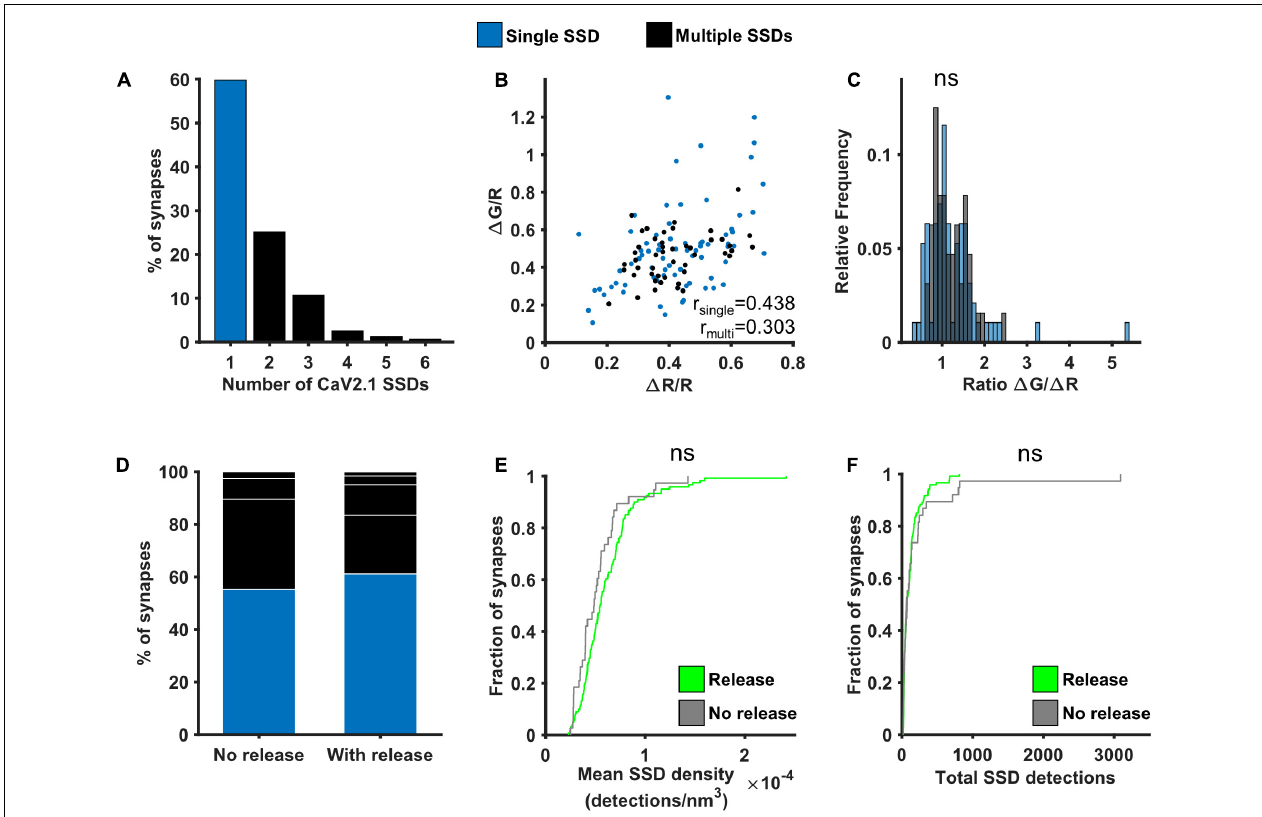
FIGURE 5 | Effect of Cav2.1 nanoscale organisation on neurotransmitter release. (A) Distribution of the number of Cav2.1 SSDs per synapse. (B) (cid:49) G/R and (cid:49) R/R responses from synapses post hoc labelled for Cav2.1 and identified as containing a single (blue) or multiple Cav2.1 SSDs (black) show a positive correlation (Spearman’s rank correlation, r single = 0.439, p < 0.0001, n single = 74 synapses; r multi = 0.303, p < 0.0001, n multi = 47 synapses). (C) Distribution of the ratio (cid:49) G/ (cid:49) R for the two group of synapses. Distributions are not significantly different (Kolmogorov-Smirnov test, p = 0.657, n single = 74, n multi = 47). (D) Percentage of synapses with single or multiple Cav2.1 SSDs in synapses without detectable release (left, n = 38) or with release (right, n = 121). White lines indicate separation of multiple SSDs by number. (E) Cumulative frequency distribution of the mean density of detections in Cav2.1 SSDs per synapse (number of detections/nm 3 ) in synapses with (green) or without (grey) detectable release to a 10AP stimulus (Kolmogorov-Smirnov test, p = 0.122, n release = 121, n norelease = 38). (F) Cumulative frequency distribution of the total number of detections in Cav2.1 SSDs per synapse in synapses with (green) or without (grey) detectable release to a 10AP stimulus (Kolmogorov-Smirnov test, p = 0.820, n release = 121, n norelease =